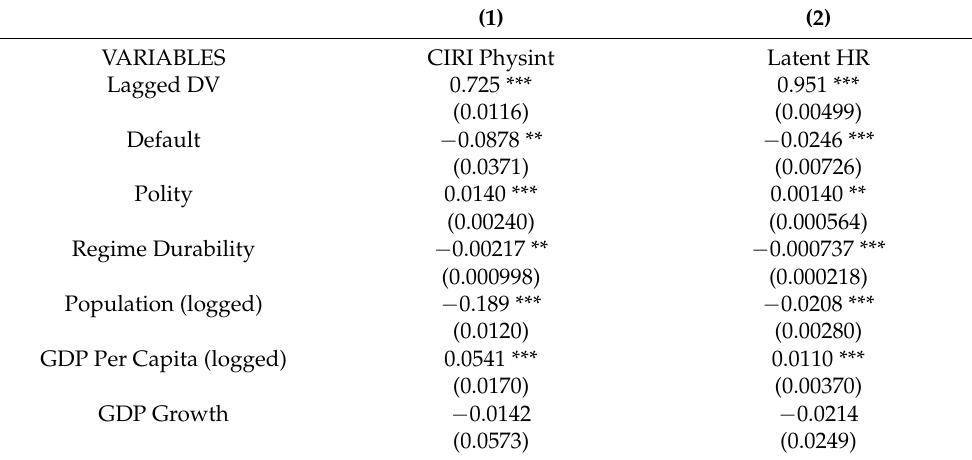
Table 1. Effects of Default on Physical Integrity